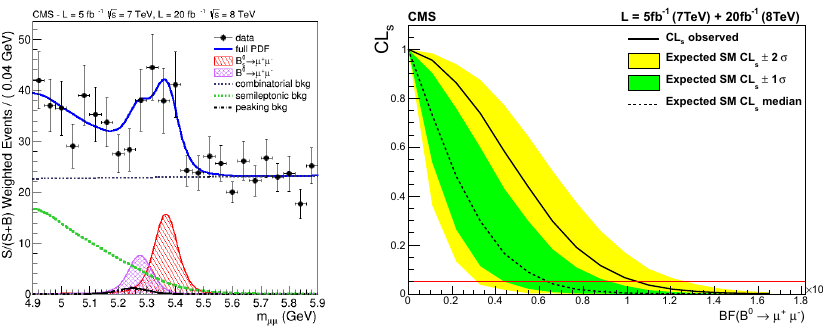
Figure 1. (Left) The weighted dimuon mass from all categorized BDT bins. The events in each category are weighted with S / (S + B), where S (B) is the number of signal (background) candidates determined at the B 0 s peak position in each bin. (Right) Expected and observed CL S for B (B 0 → μ + μ − ) as a function of the assumed branching fraction